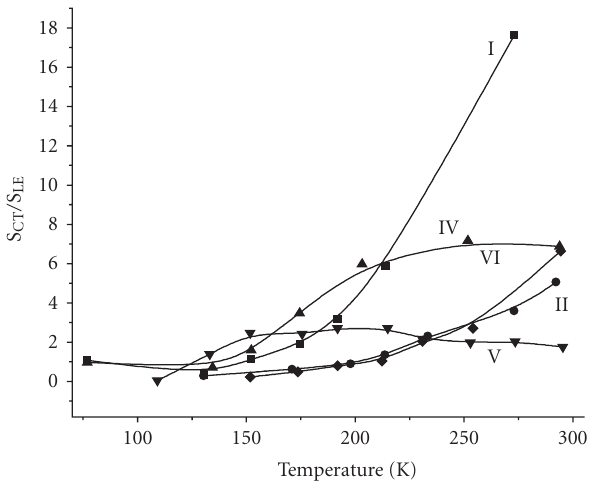
Figure 3: The ratios of the areas under the longwavelength (CT) and the shortwavelength (LE) fluorescence bands of the compounds I, IV, V in ethanol and II and VI in butyronitrile at various temper- atures in the range 293–100 K.